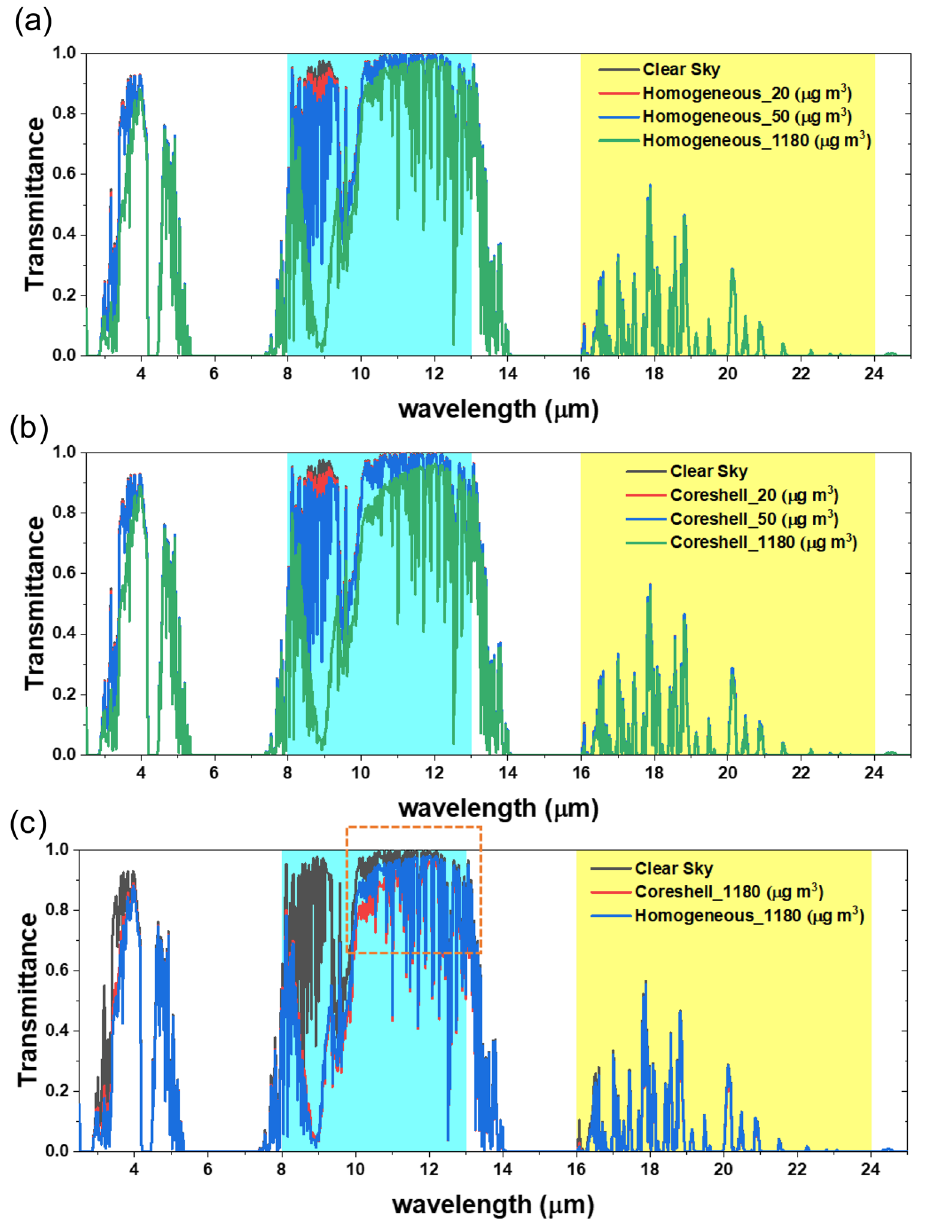
Fig. 4 The atmospheric transmittance in the absence and presence of PM. a Presence of homogeneous sulfate, and b Presence of sulfate/SiO 2 core/shell mixtures at different concentrations from 20, 50 to 1,180 μ g m − 3 . c Presence of homogeneous sulfate and sulfate/SiO 2 core/shell mixtures at same concentrations 1,180 μ g m − 3